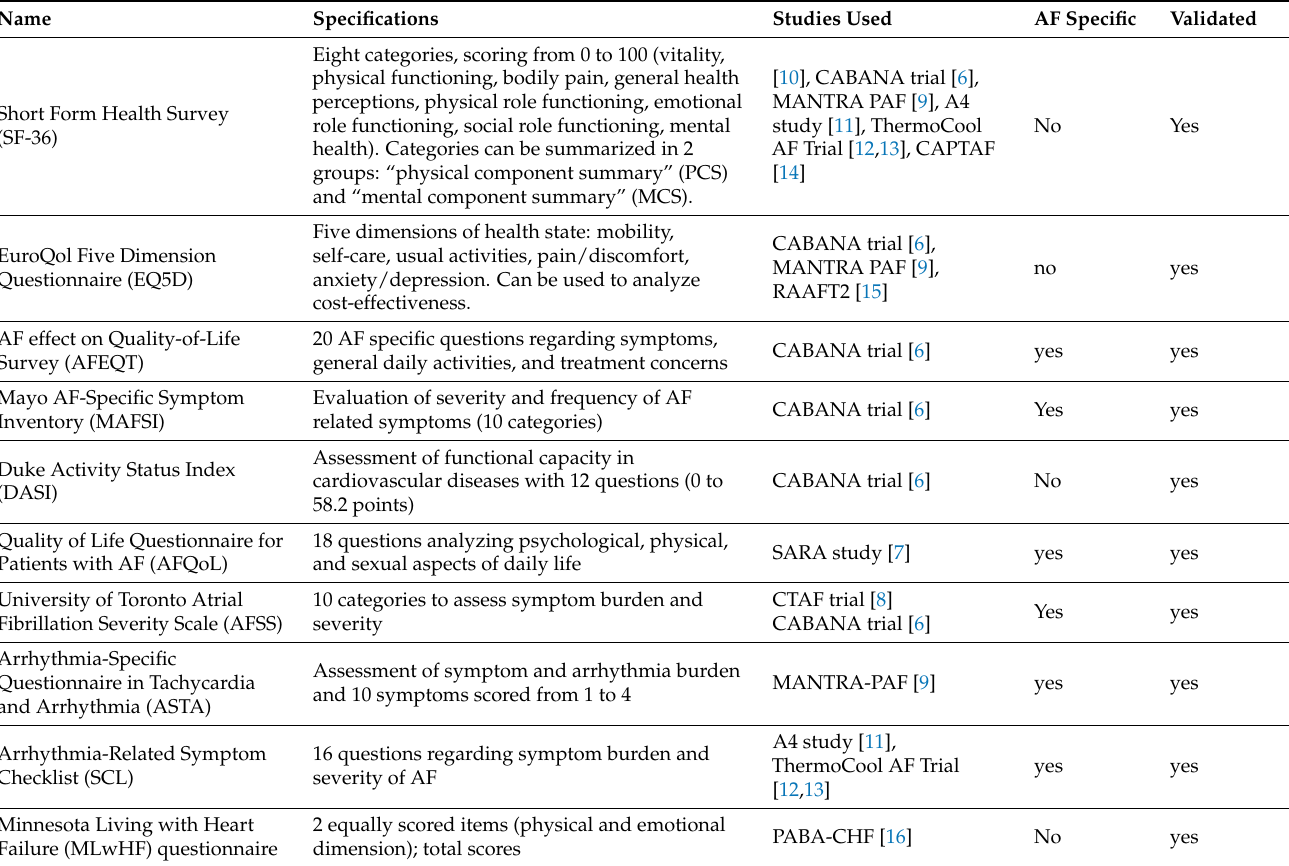
Table 1. Overview of QoL